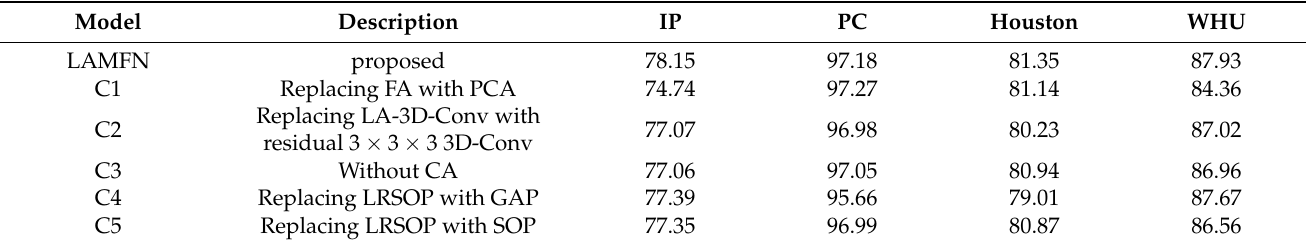
Table 8. OA results (%) of ablation model experiments.